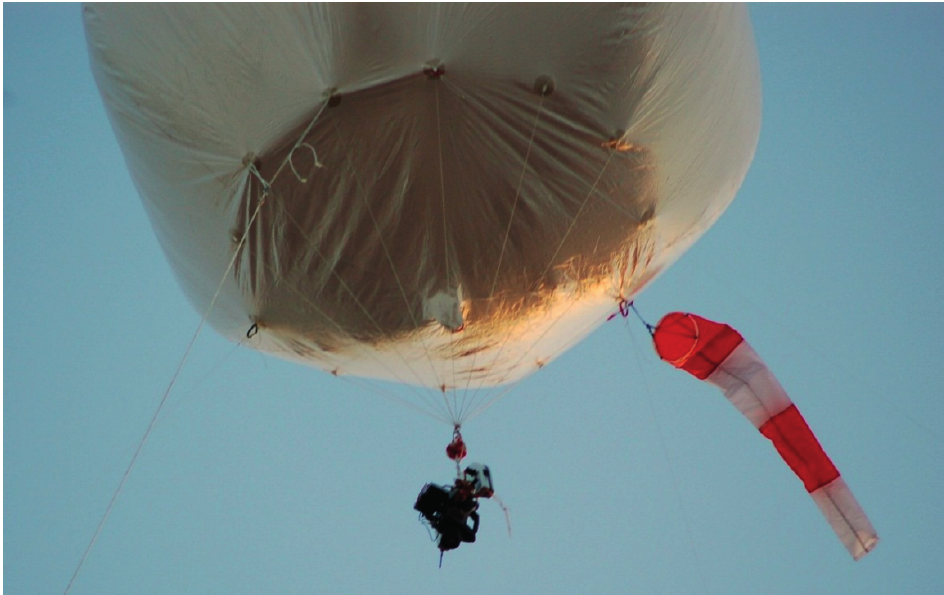
Figure 5. The monitoring